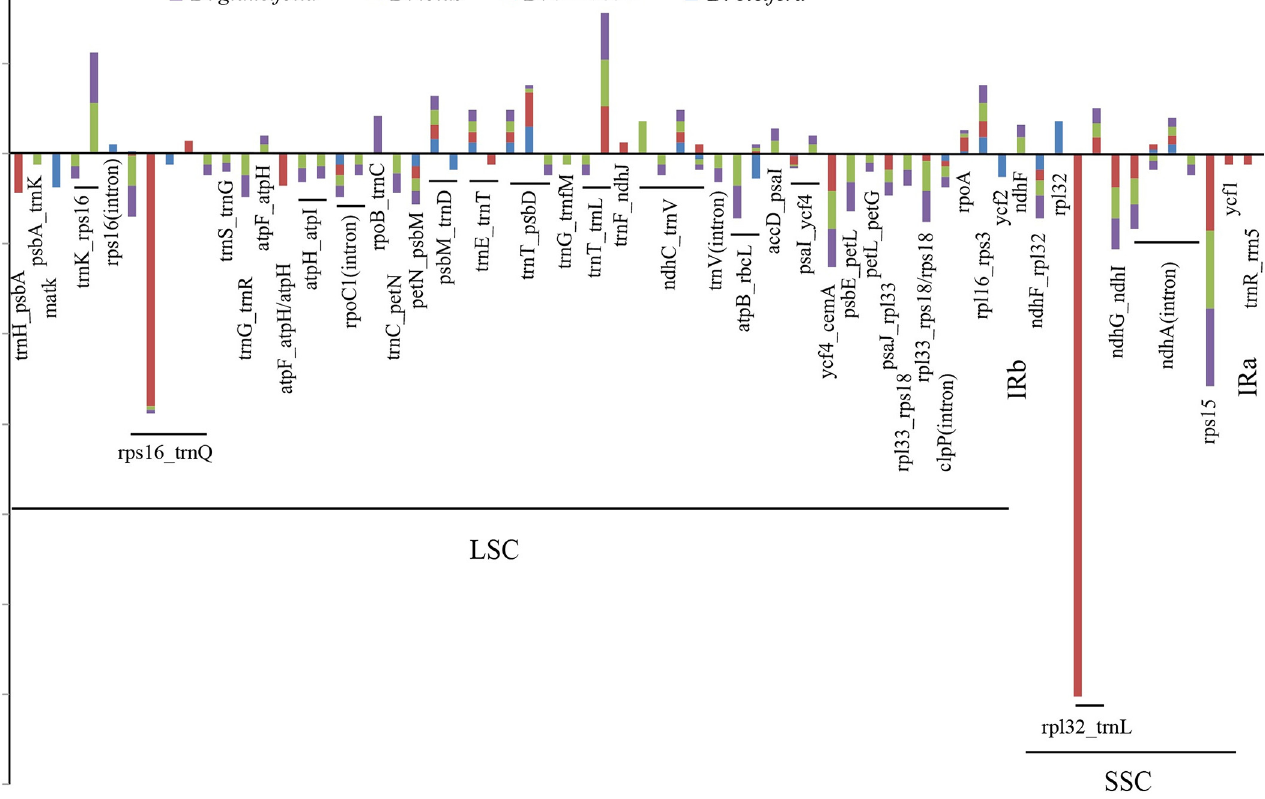
PLOS ONE | DOI:10.1371/journal.pone.0159566 July 21,